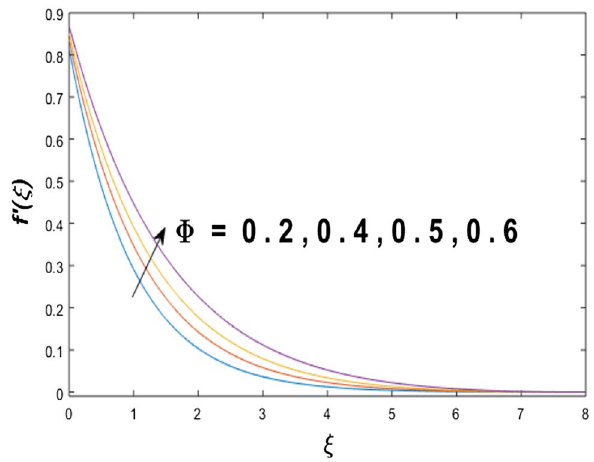
Figure 2. Variations of (cid:31) to f ′ (ξ)